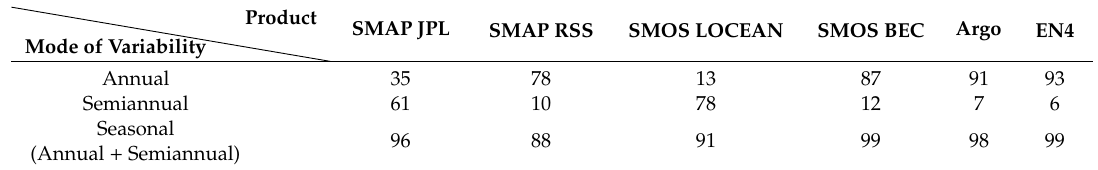
Table 2. Percentage of SSS variances in the SPNA that can be explained by the annual, semiannual, and seasonal (annual + semiannual)